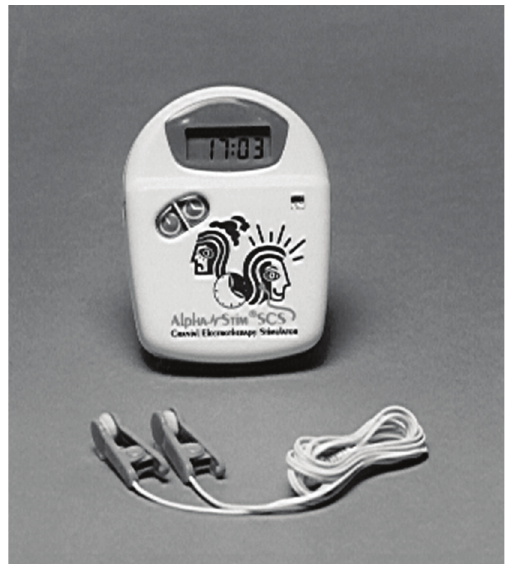
Figure 1: Cranial electrostimulation therapy (CES)